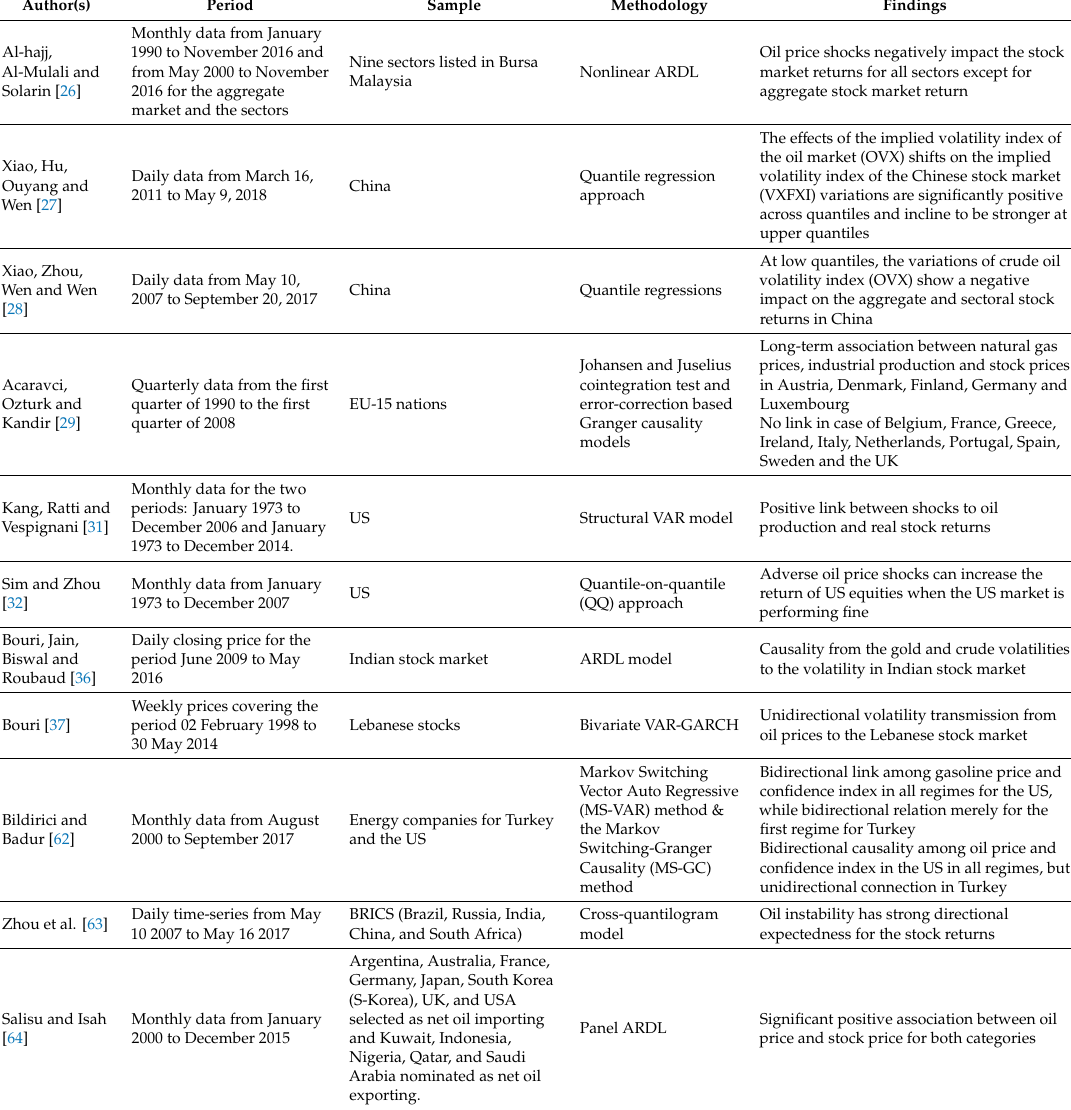
Table 1. Previous related studies on the linkage between energy markets and stock